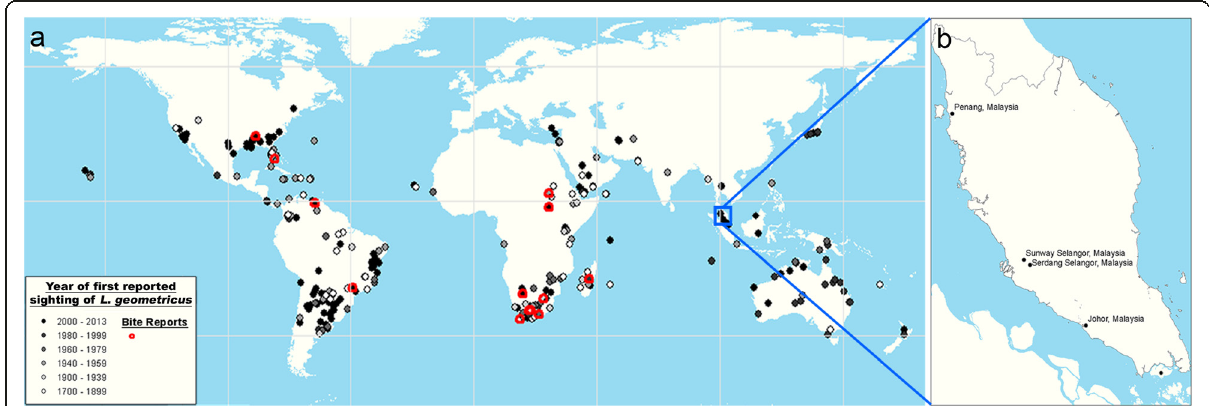
Figure 1 Distribution of reported sightings of Latrodectus geometricus. (a) Map showing the global distribution of Latrodectus geometricus [1,2,7,11,12,19,21-24,27-127]. (b) Locations in the northwest, central and south of Peninsular Malaysia with new records of the brown widow